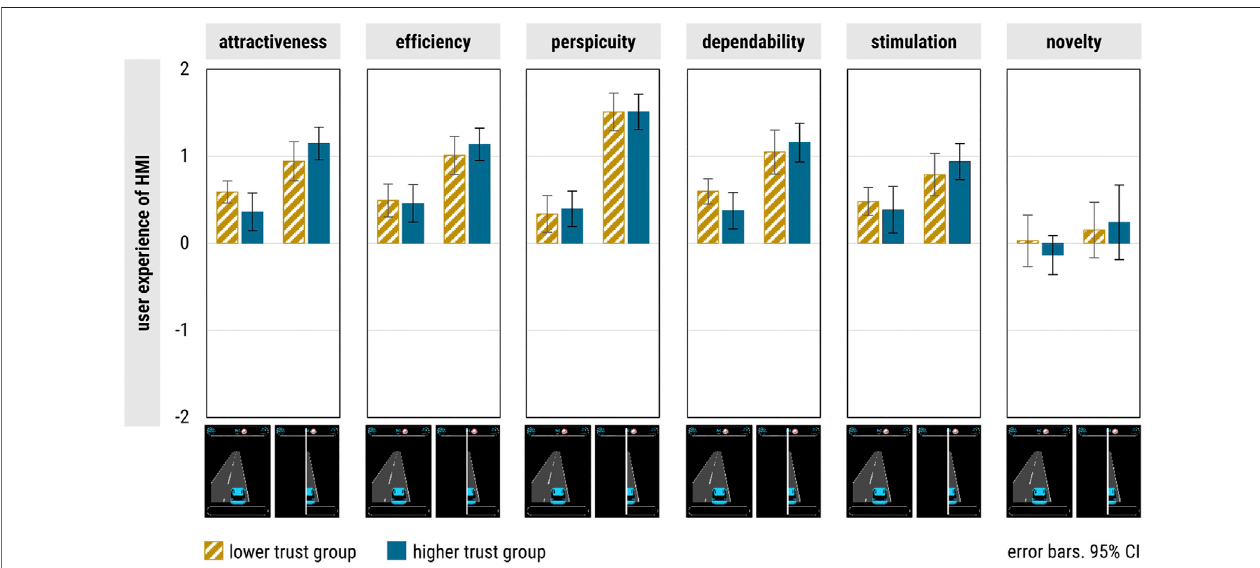
FIGURE 6 | Trust group-speci fi c user experience provided by the permanent (left) and context-adaptive (right) HMI.